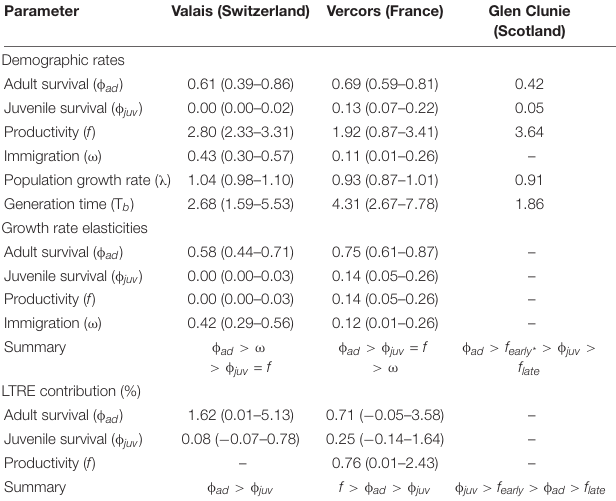
TABLE 1 | Posterior means (with 95% credible intervals) of demographic rates, generation time and results from prospective (elasticities) and retrospective (transient LTRE) perturbation analyses as obtained from integrated population models for two ring ouzel ( T. t. alpestris ) populations in the Alps (Valais and